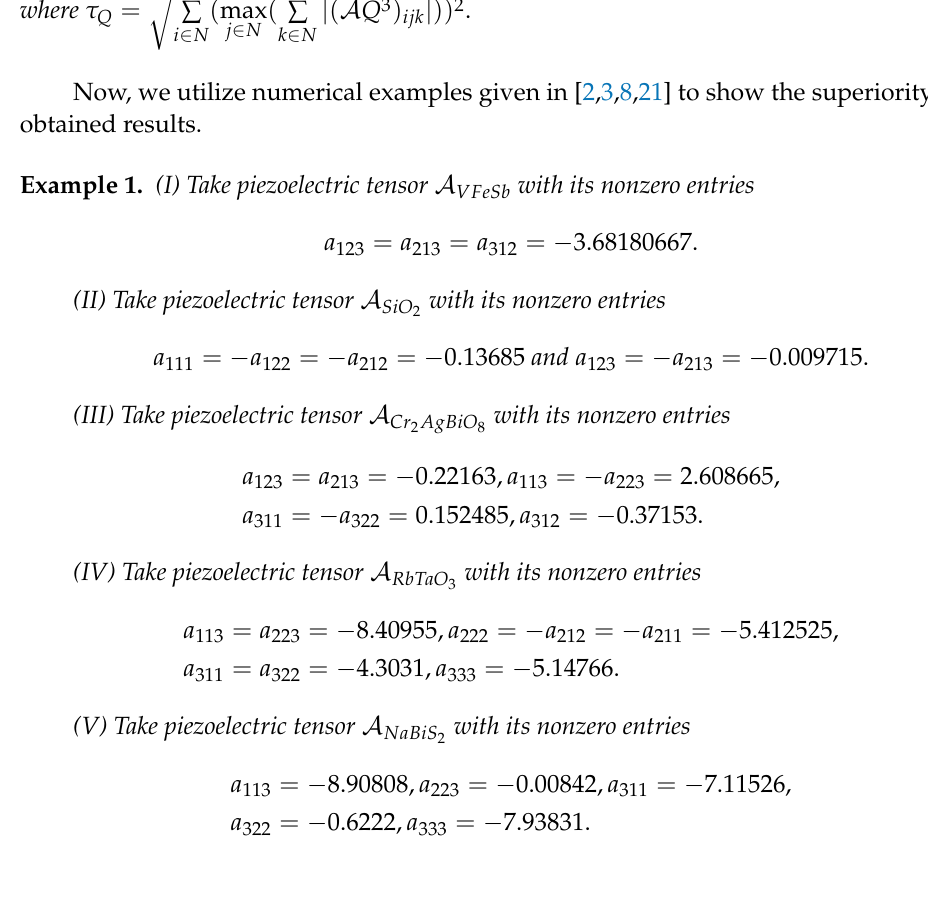
Q 3 and A KBi 2 F 7 2 F 7